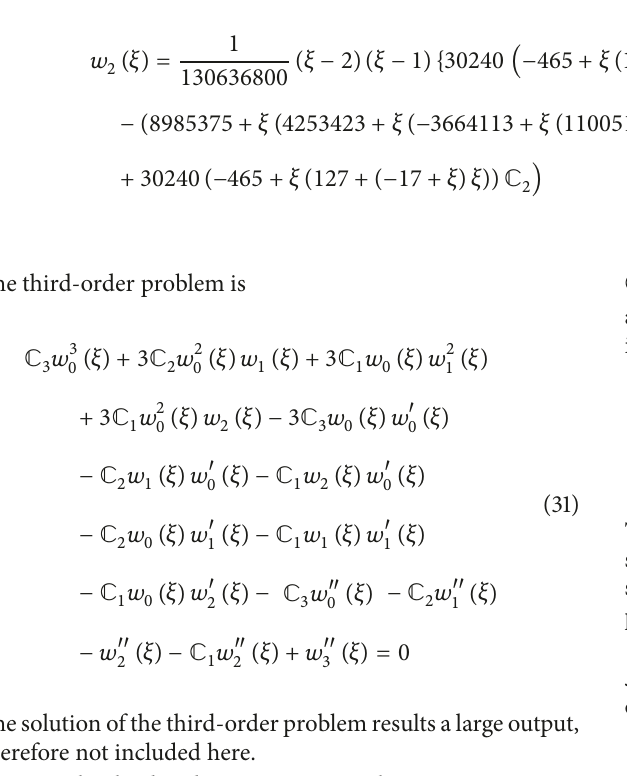
The solution of (29)